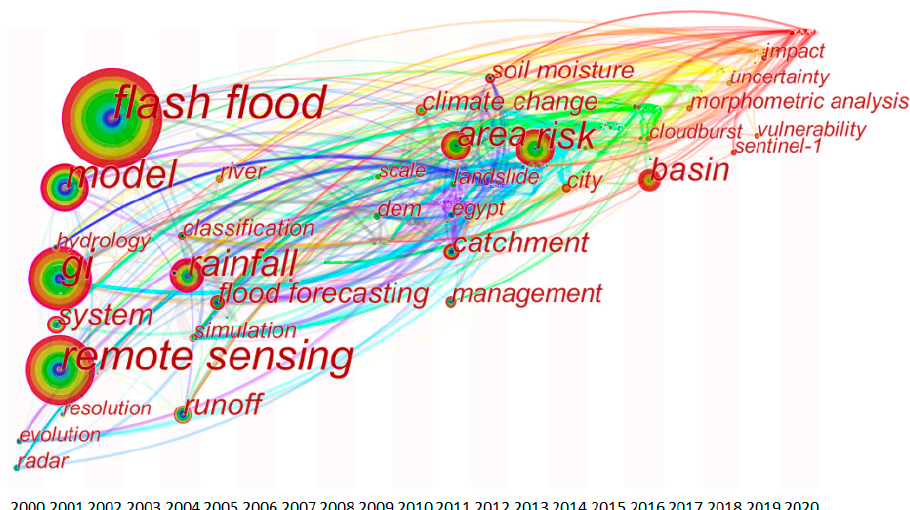
Figure 4. A time zone map of keywords.